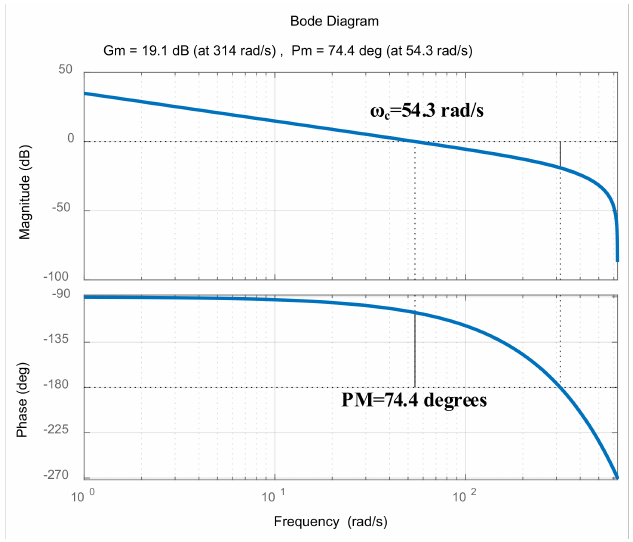
Figure A2. Bode plot of the voltage loop. The achieved phase margin is 74.4 degrees, which is high enough for stability. The cross-over frequency is 54.3 rad/s, which is consistent with the response time in Figure